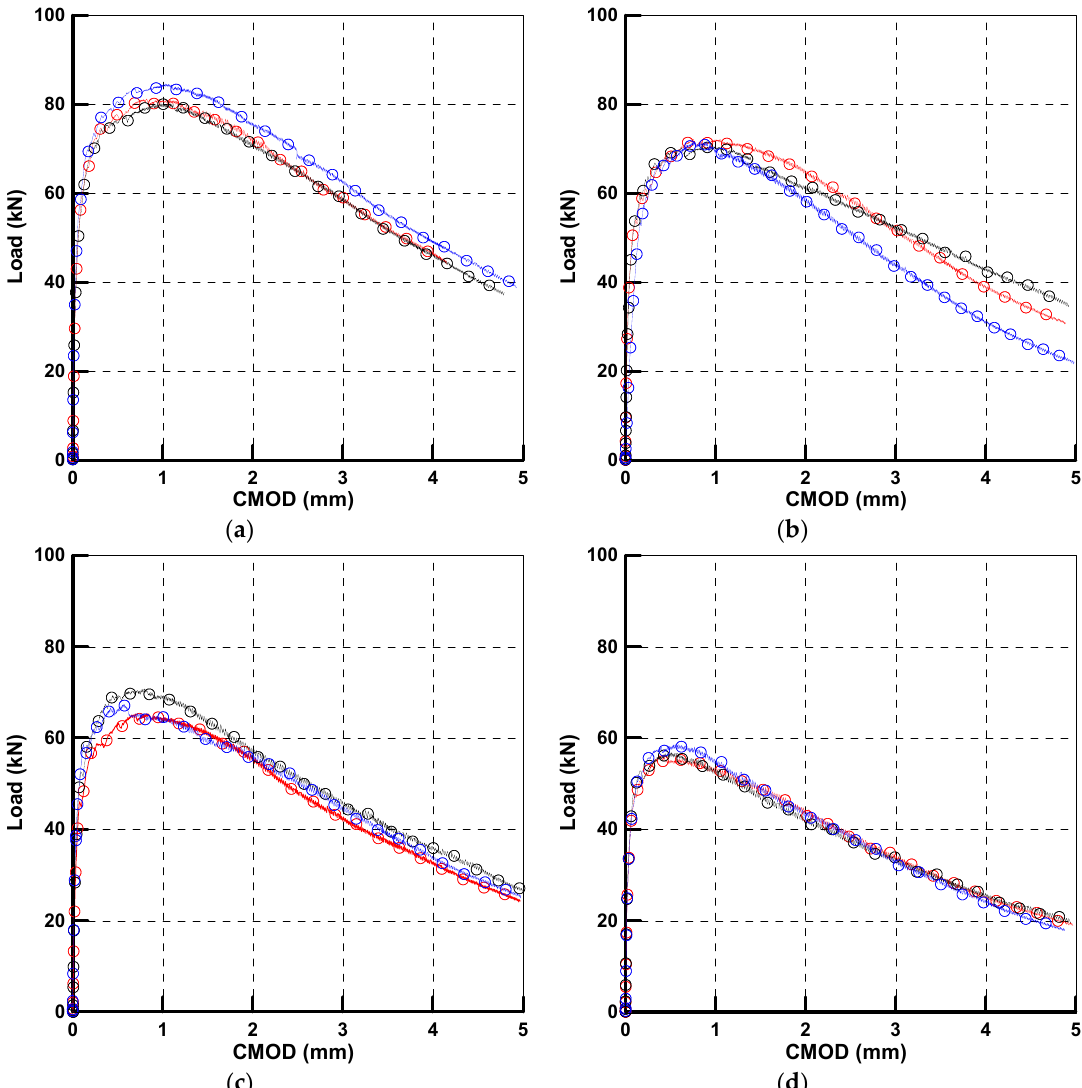
Figure 8. Load-CMOD curves with different mixes: ( a ) Mix 1, ( b ) Mix 2, ( c ) Mix 3, and ( d ) Mix 4. Table 2. Flexural test